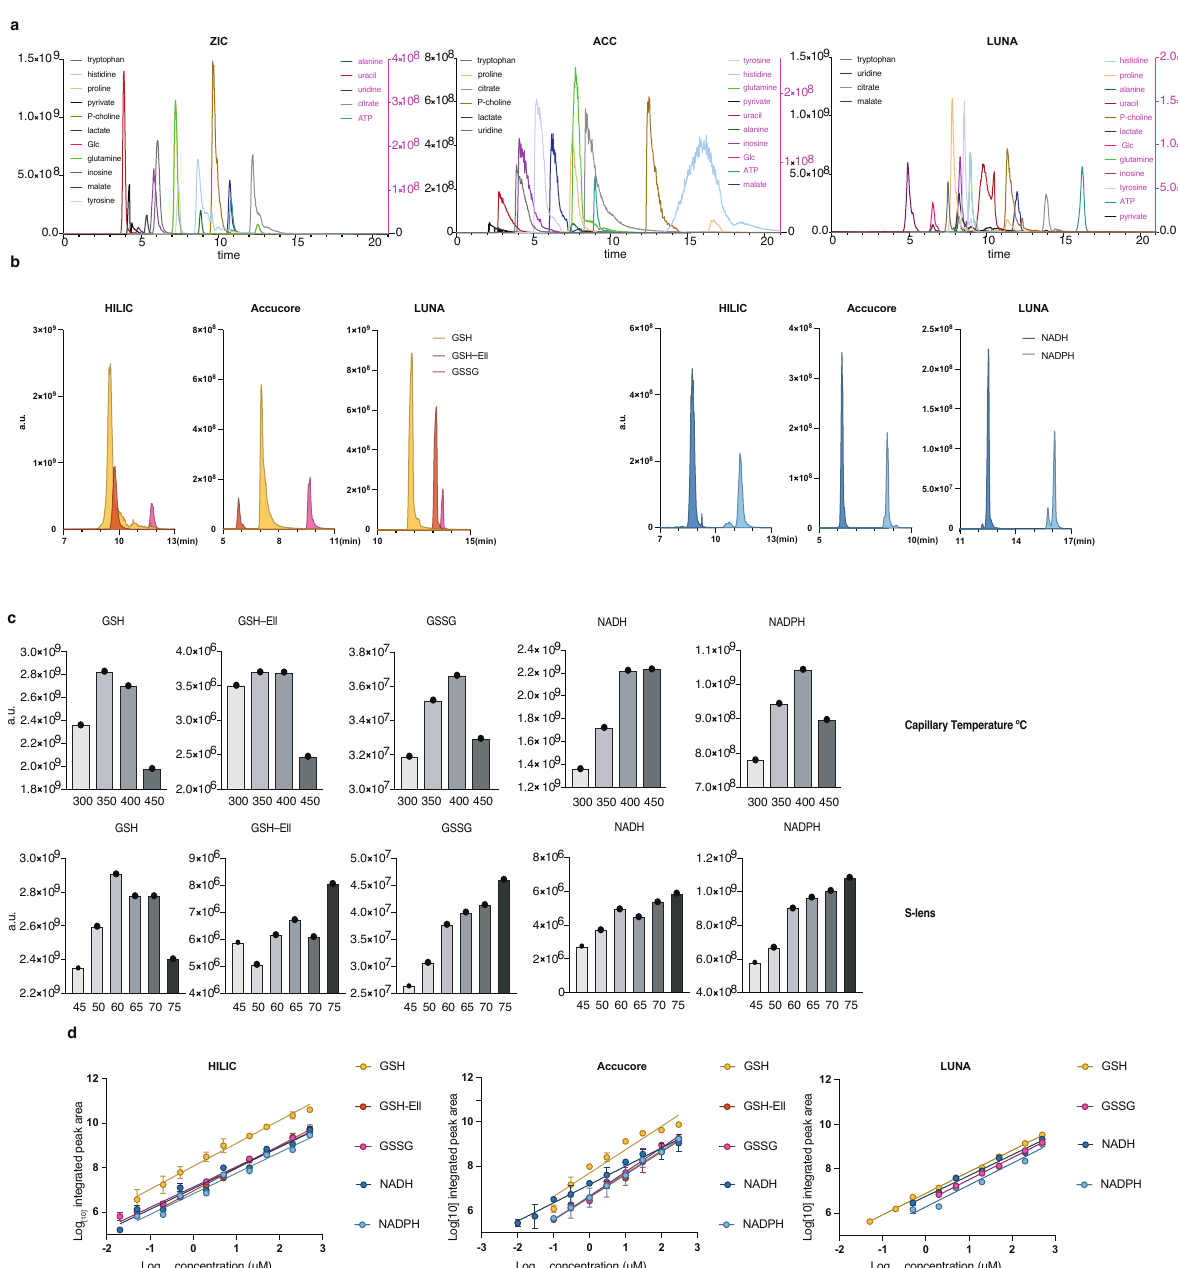
Figure 1. A method to quantify redox metabolites by LC-MS; ( a,b ) Retention times and sensitivity comparison between